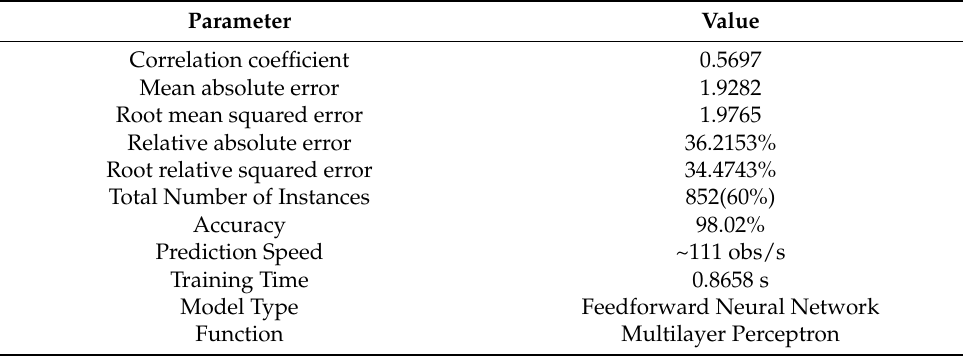
Table 4. Multilayer Perceptron Characterization.